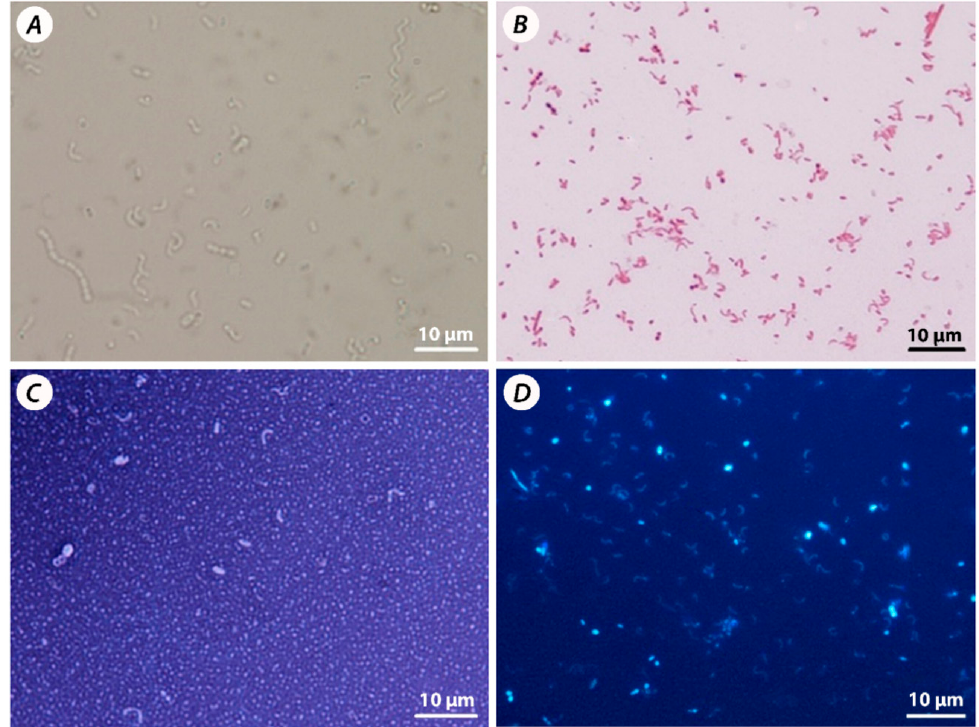
Figure 2. Sulfate-reducing bacteria (SRB) mixed culture: native slide ( A ), Gram staining ( B ), capsule staining ( C ), DAPI staining ( D ).